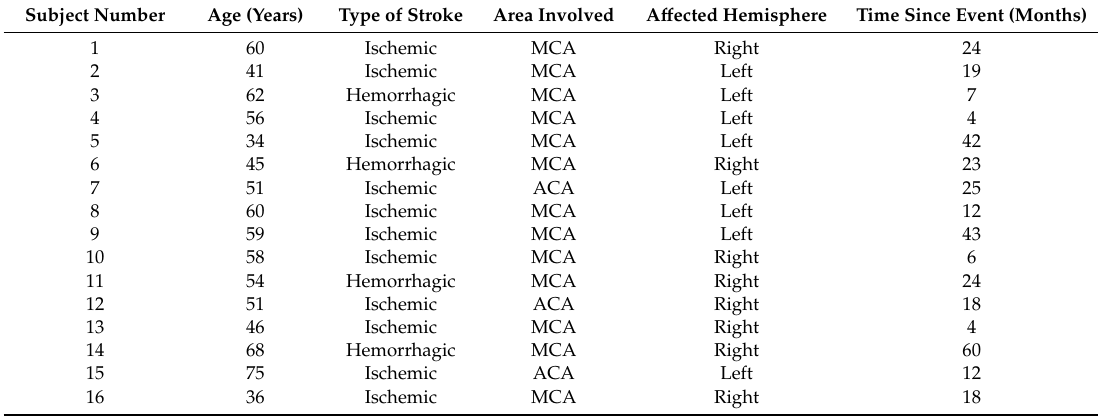
Table 1. Characteristics for each patient participating in the study. Middle cerebral artery (MCA) and anterior cerebral artery